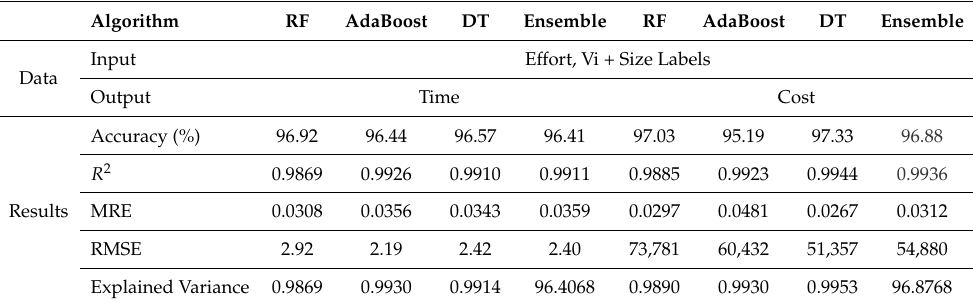
Table 15. Evaluation metrics for all algorithms used in the